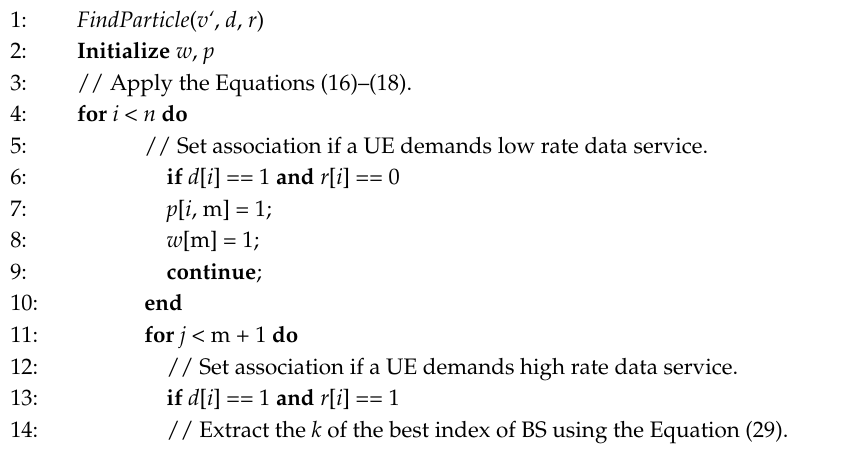
Algorithm 2. Find